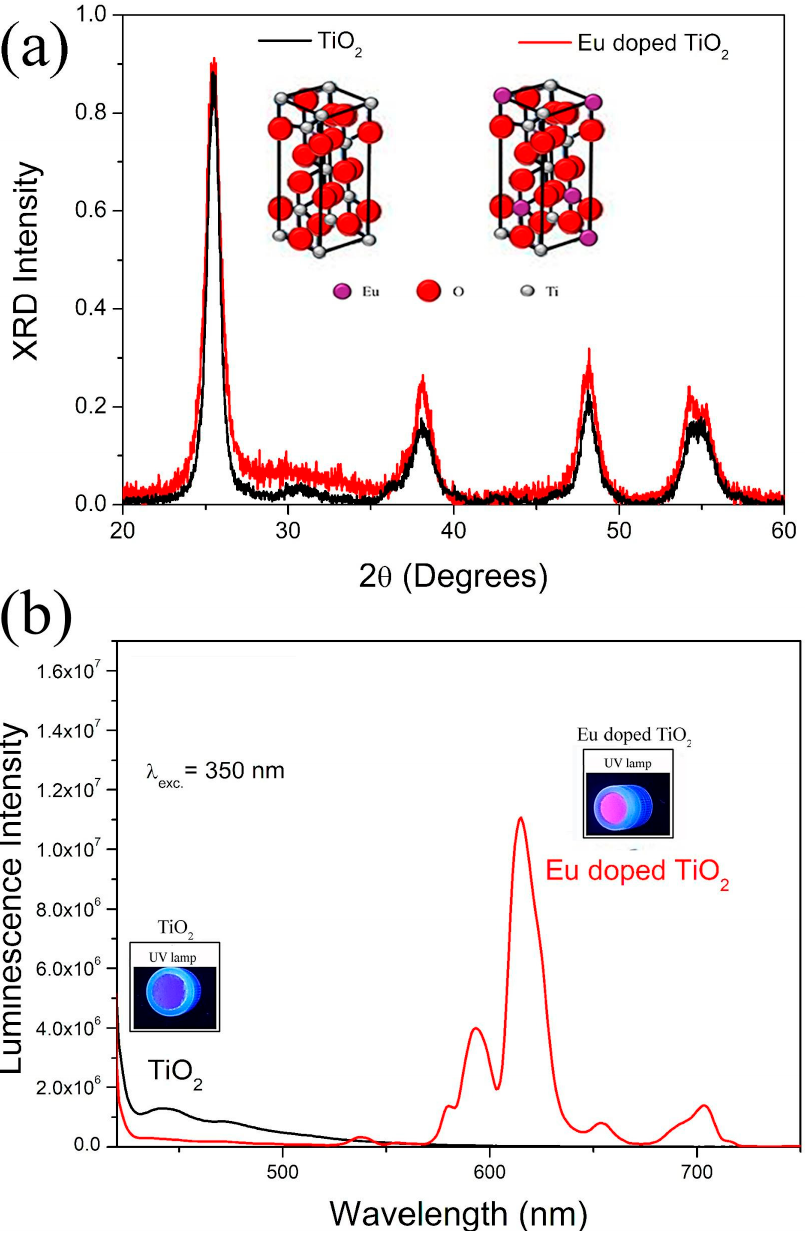
Figure 1. ( a ) XRD patterns and ( b ) luminescence spectra of TiO 2 and Eu 3+ -doped TiO 2 (TiO 2 :Eu) nanocrystals.